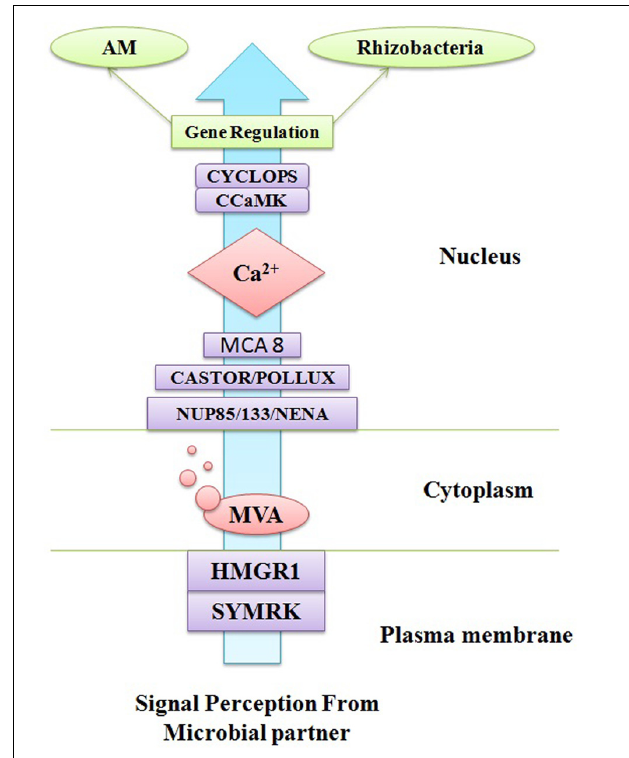
FIGURE 2 | A common signaling pathway triggers in plant cell during microbial